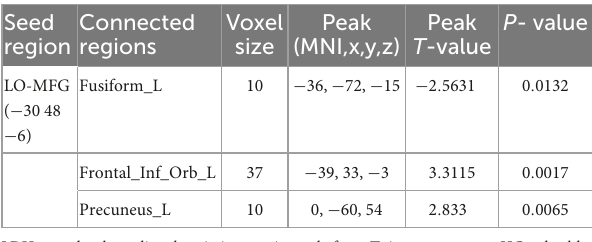
TABLE 3 Significantly different regions in dFC variance between LDH-pre patients and